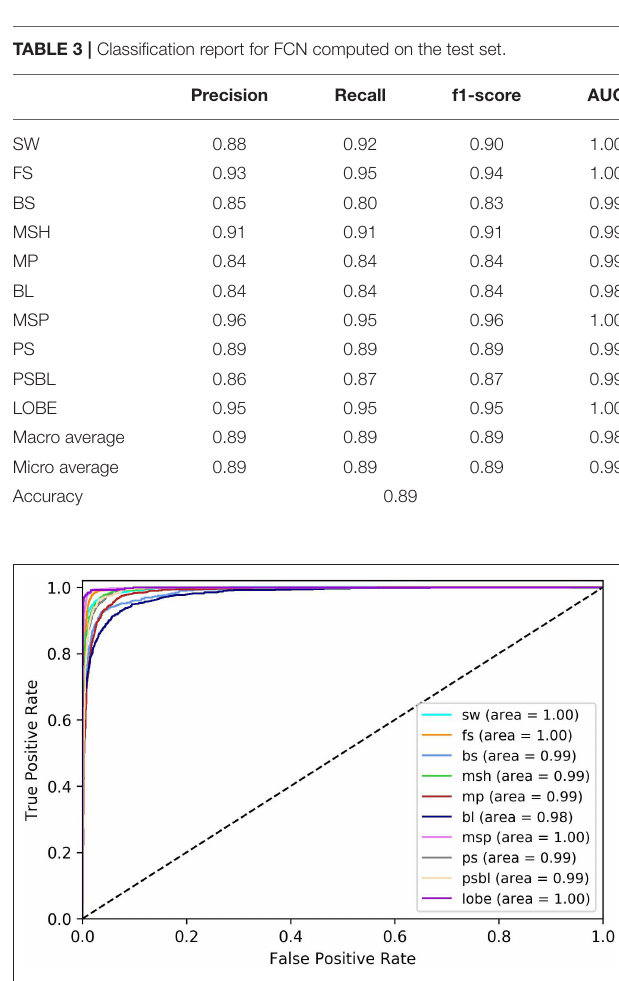
FIGURE 2 | Receiver operating characteristic curve computed on the test